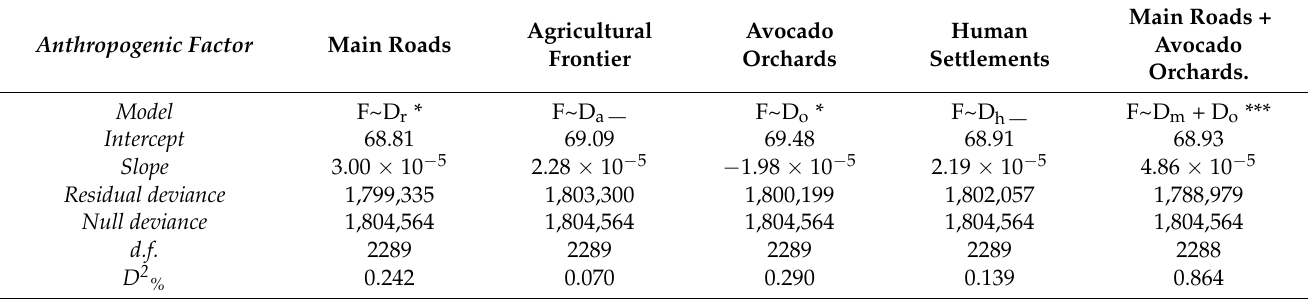
Figure A1. Reported causes behind fires on MAB from 2000 to 2017. Until 2006, causes were not specified in the records. Wildfires correspond to lightning strikes as natural causes. Table A4. GLM summary between fire recurrency and anthropogenic